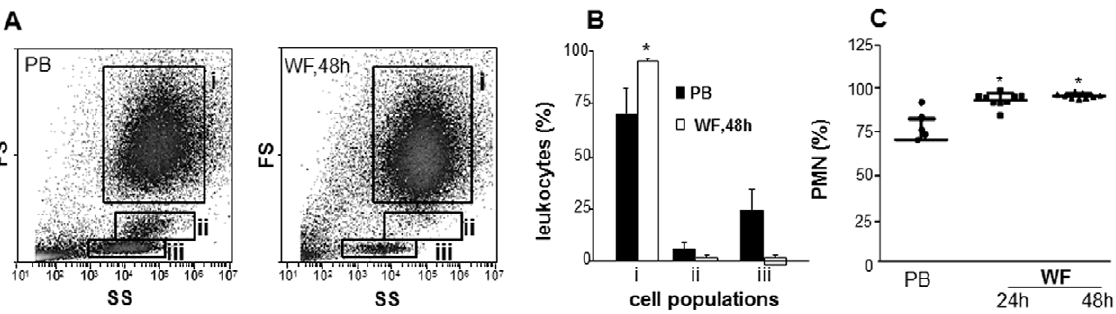
Figure 2. Cells in sternotomy wound-fluid are predominantly PMN. Wound cells isolated from WF were subjected to flow cytometry analysis. A , forward and sideward scatter (FS/SS) and flow cytometry analysis to sub-fraction wound and blood leukocytes. Based on FS/SS characteristics of blood leukocytes (PB, before surgery), three major cell populations were gated: gatei , granulocytes; gateii , monocytes; gateiii , lymphocytes; B , quantification of cells in each of the three gates (i–iii). Solid bar, blood at baseline; open bars, WF cells at 48 h post-surgery. Data are mean 6 SD, n=4. C , Neutrophil count expressed in % of total leukocytes as determined by microscopic differential count. Data presented as mean 6 SD, n=7. * p , 0.05 compared to PB.